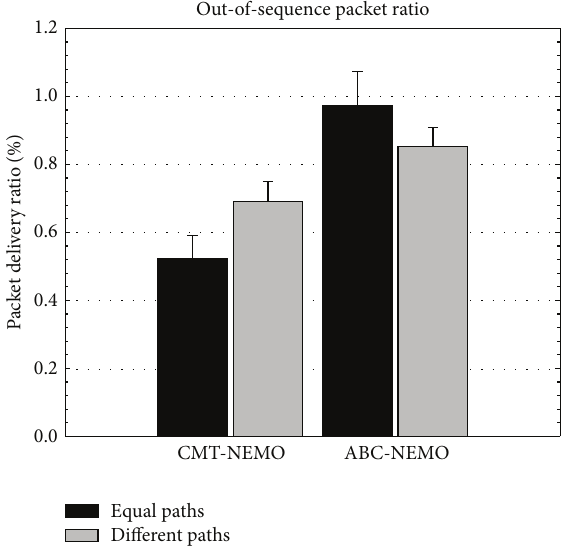
Figure 16: Comparison of out-of-sequence packet delivery